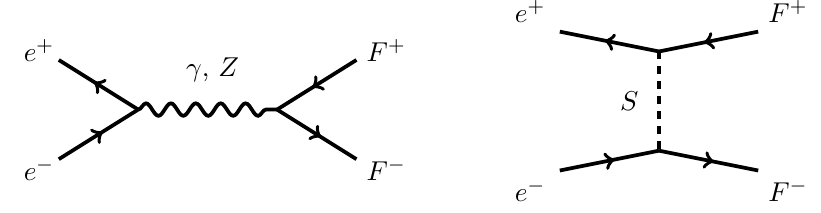
Figure 2 . Feynman diagrams for F + F (cid:0) pair production at LEP. The s -channel production is (cid:12)xed by the fermion’s quantum numbers, while the t -channel production depends on the scalar’s mass and the strength of the Yukawa interaction between the charged fermions and the